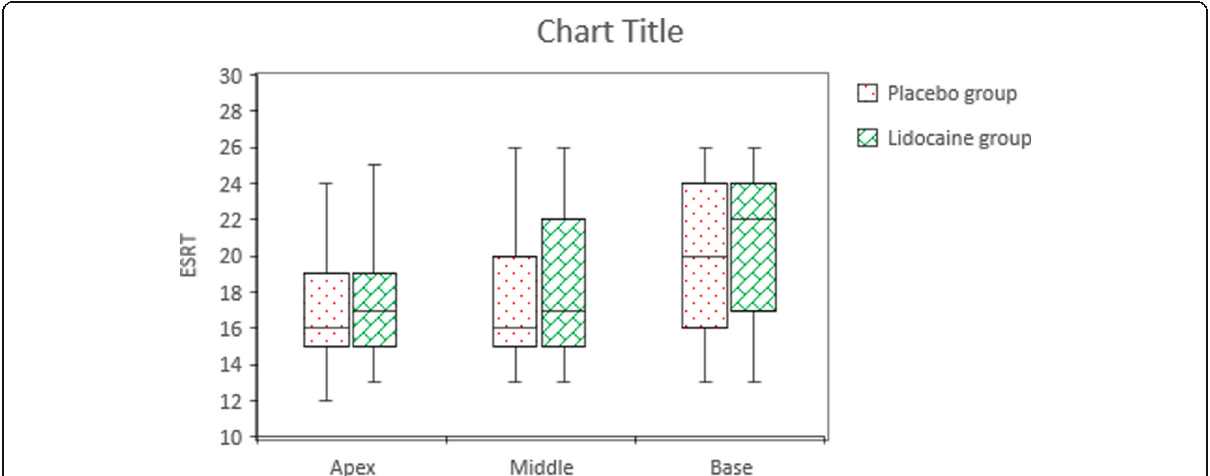
Fig. 2 Box plots of the ESRT in both groups at the apex, middle, and base of the electrode. The median (IQR) values are shown as a solid line within the box of 25th and 75th percentile values. Whiskers represent 5th and 95th percentile values. ESRT electrical stapedial reflex threshold. No significant difference between groups, P > 0.05